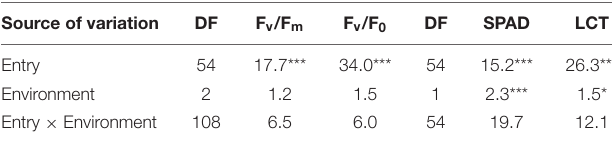
TABLE 5 | Genotypic and environmental effects and their interaction on the physiological parameters of barley lines selected under ultra-low density when evaluated under dense stand trials in different environments in